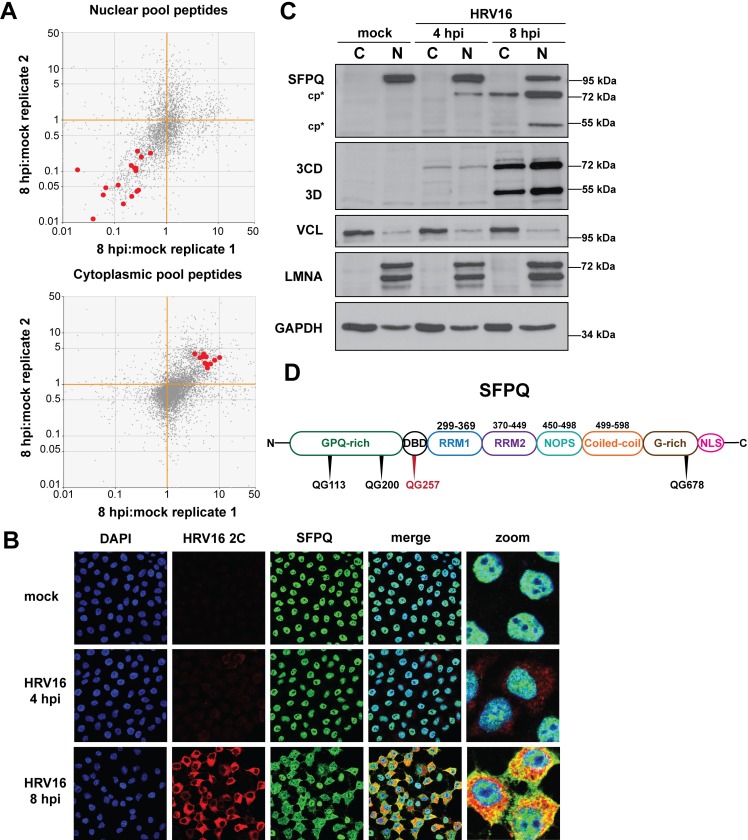
Splicing factor proline and glutamine rich (SFPQ) migrates from the nucleus to the cytoplasm following HRV16 infection.(A) Tryptic peptides in Fig 2 that correspond to SFPQ are highlighted red as described in the legend for Fig 3. (B) HeLa cells were mock- or HRV16-infected (MOI 10) and fixed then imaged as described in the legend for Fig 4. (C) Western blot analysis of cytoplasmic (C) and nuclear (N) fractions of mock- or HRV16-infected HeLa cells. A C-terminal cleavage product (cp*) was detected in the cytoplasm at 8 hours post infection (hpi). A second cleavage fragment of SFPQ was detected in the nucleus at 8 hpi (cp*). HRV16 3D/3CD,VCL, LMNA, and GAPDH used as in Fig 4. (D) Schematic of SFPQ domains (adapted from [86]) with putative 3CD/3C cleavage sites. The proposed 3CD/3C cleavage site resulting in the fragment observed 4 hpi is indicated in red. The N-terminal portion of SFPQ includes the glycine, proline, and glutamine-rich (GPQ-rich) and DNA-binding domain (DBD). The C-terminal portion contains two RNA-recognition motifs (RRM1 and RRM2), a NonA/paraspeckle (NOPS) domain, a coiled-coiled domain, glycine-rich (G-rich) region, and nuclear localization signal (NLS).